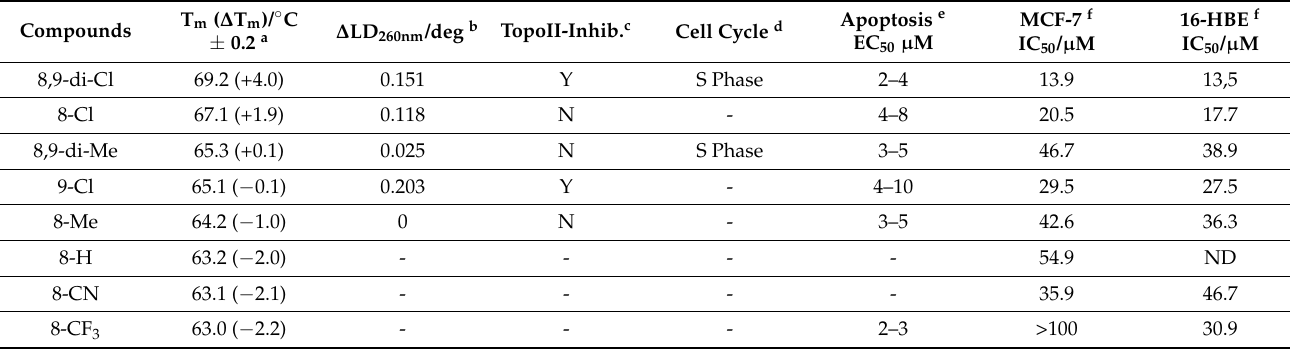
Table 1. Effects PBTs on c-myc melting temperature (T m ), linear dichroism (LD) data on duplex DNA ( ∆ LD 260nm ) b , and other biological properties. Compounds are listed following the thermal stability order, starting from the most stable. Compounds